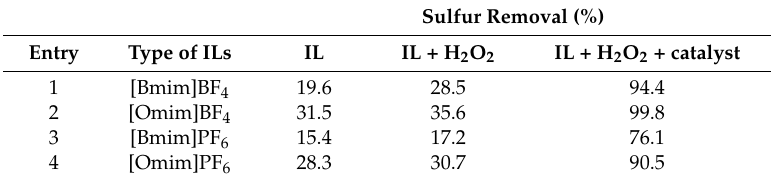
Table 1. Oxidation of dibenzothiophene (DBT) in different desulfurization systems. Sulfur Removal